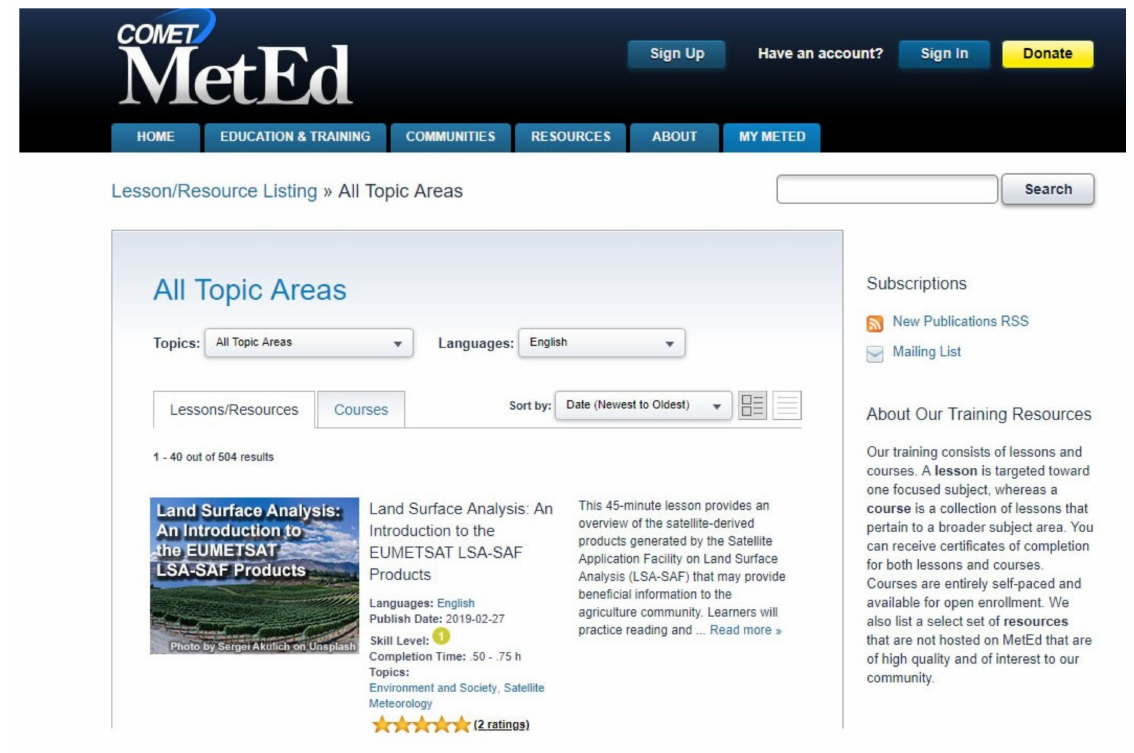
Figure 7. Screenshot of the MetEd education and training page, showing an example satellite training lesson that demonstrates land surface analysis using satellite products. On the right is a description of COMET’s lessons versus full distance learning